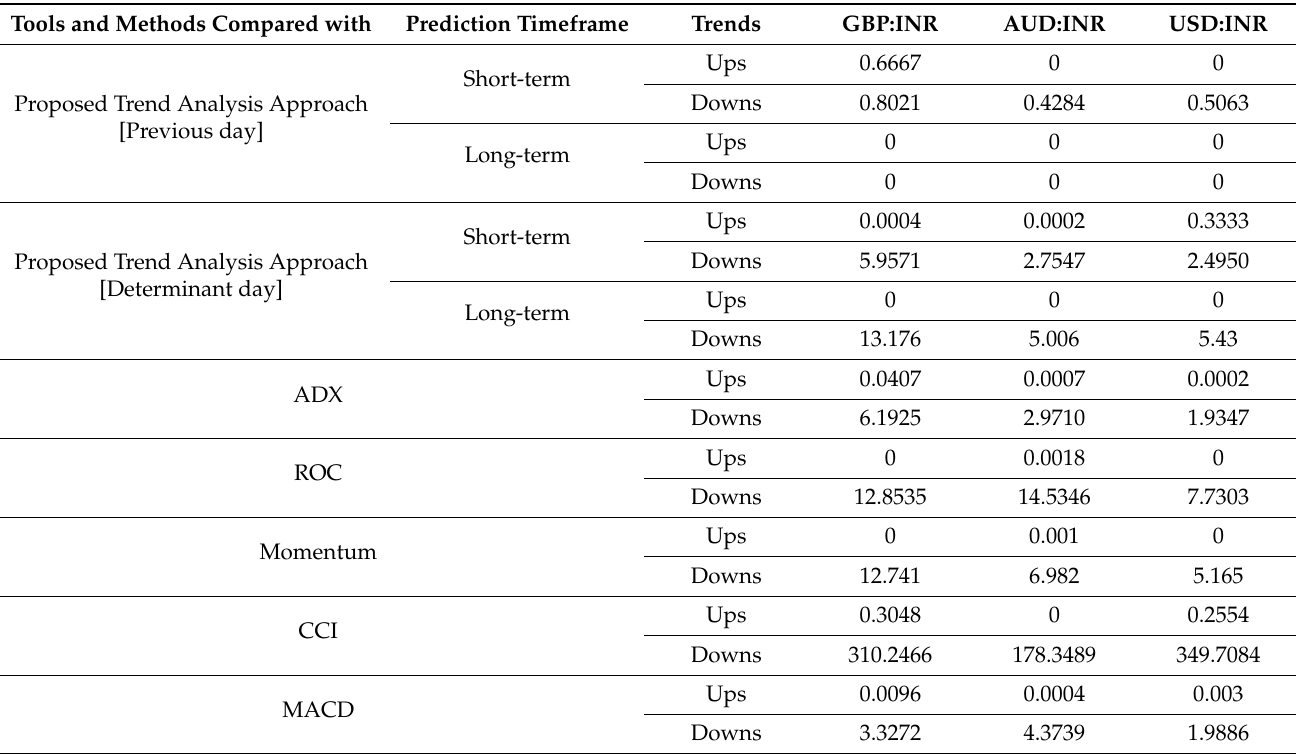
Table 11. Minimum units up and down (return results) observed for three currency pairs.